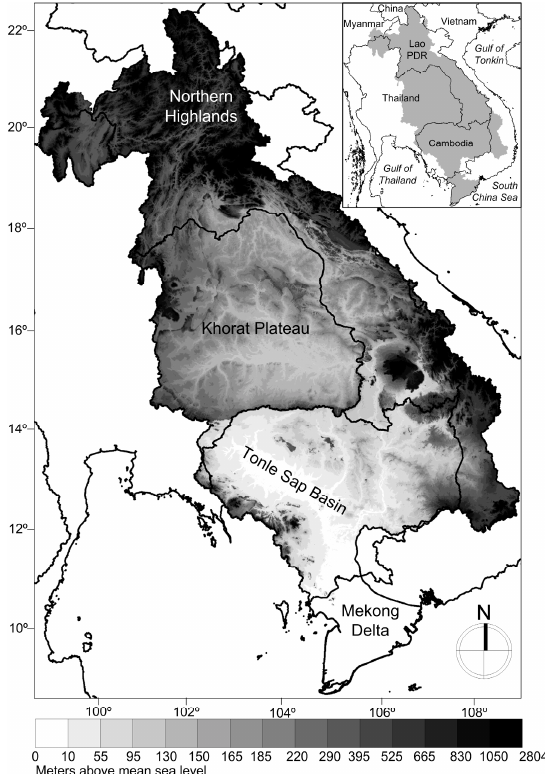
Figure 1. Topography of the Lower Mekong Basin. Elevations are derived from